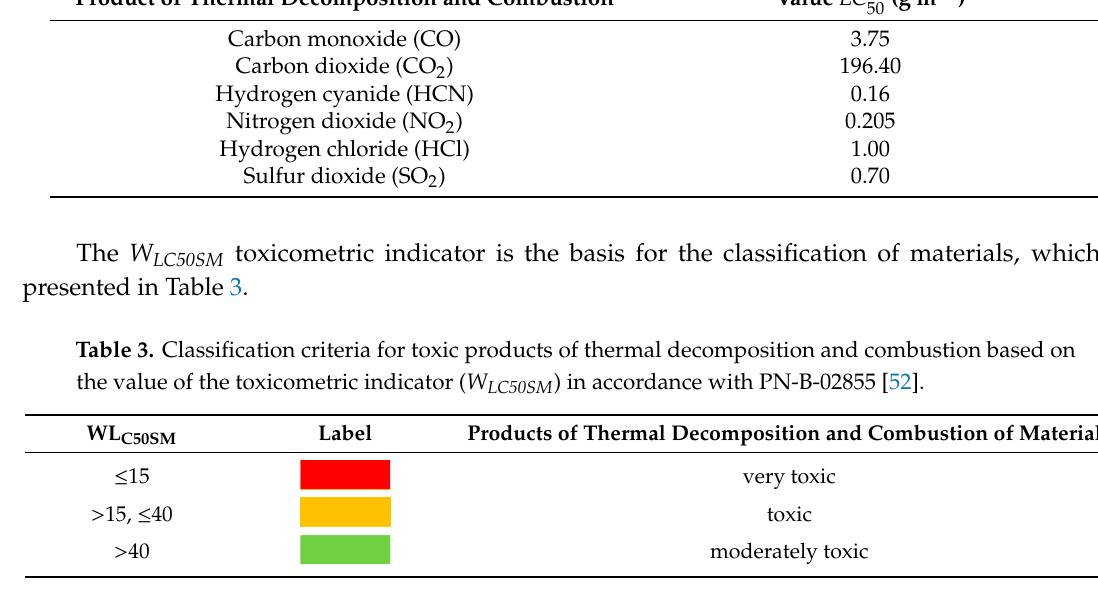
Table 2. Indicators of limit concentration of products of thermal decomposition and combustion ( LC 30 Product of Thermal Decomposition and Combustion